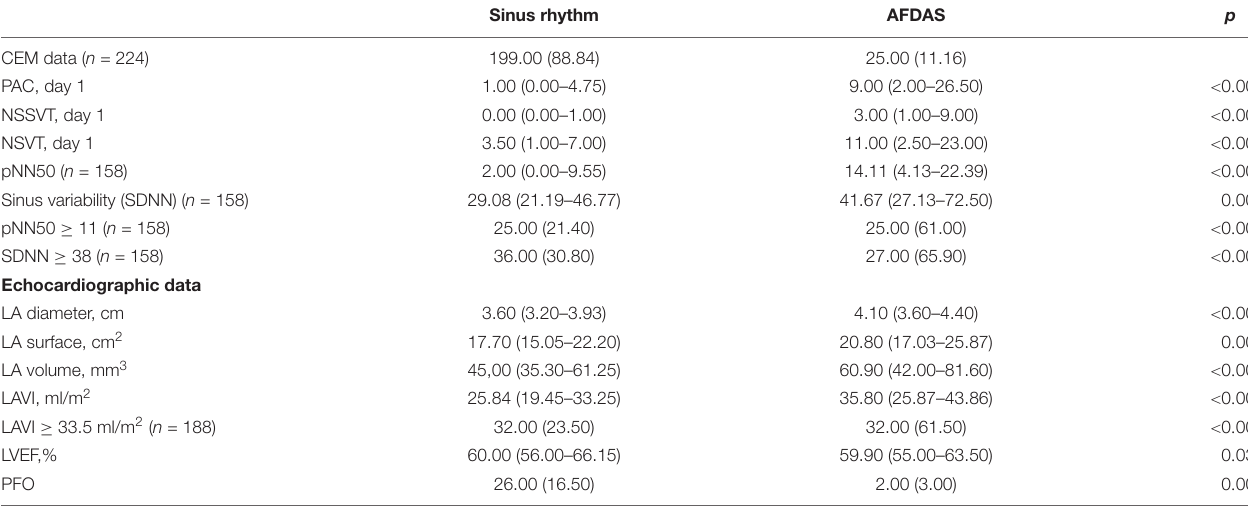
TABLE 3 | cardiac work-up [ n (%) or median (IQR)].